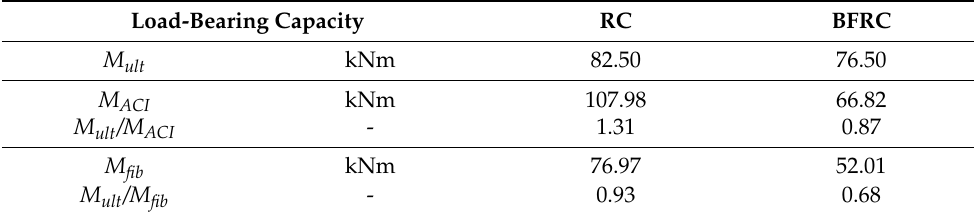
Table 6. Experimental M ult and the designed load-bearing capacity of beams. Load-Bearing